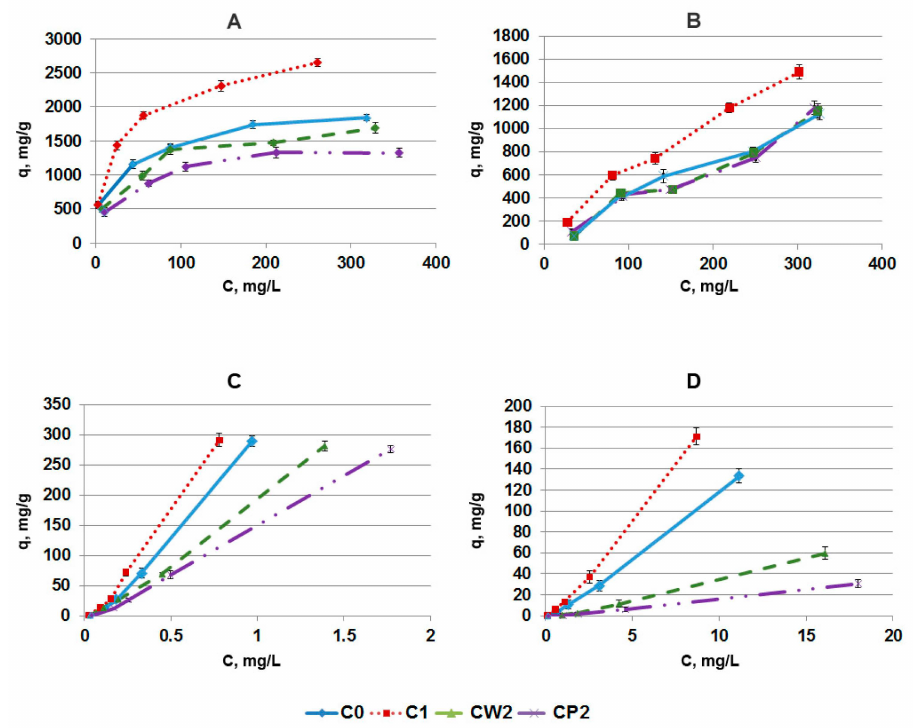
Figure 6. Adsorption isotherms of SRL (high concentrations) onto different fractions of AC in PBS ( A ) and BP ( B ). Adsorption isotherms of SRL (low concentrations) onto different fractions of AC in PBS ( C ) and BP ( D ). Table 2. The parameters calculated from the adsorption isotherms of SRL onto AC fractions according to the Freundlich and Langmuir